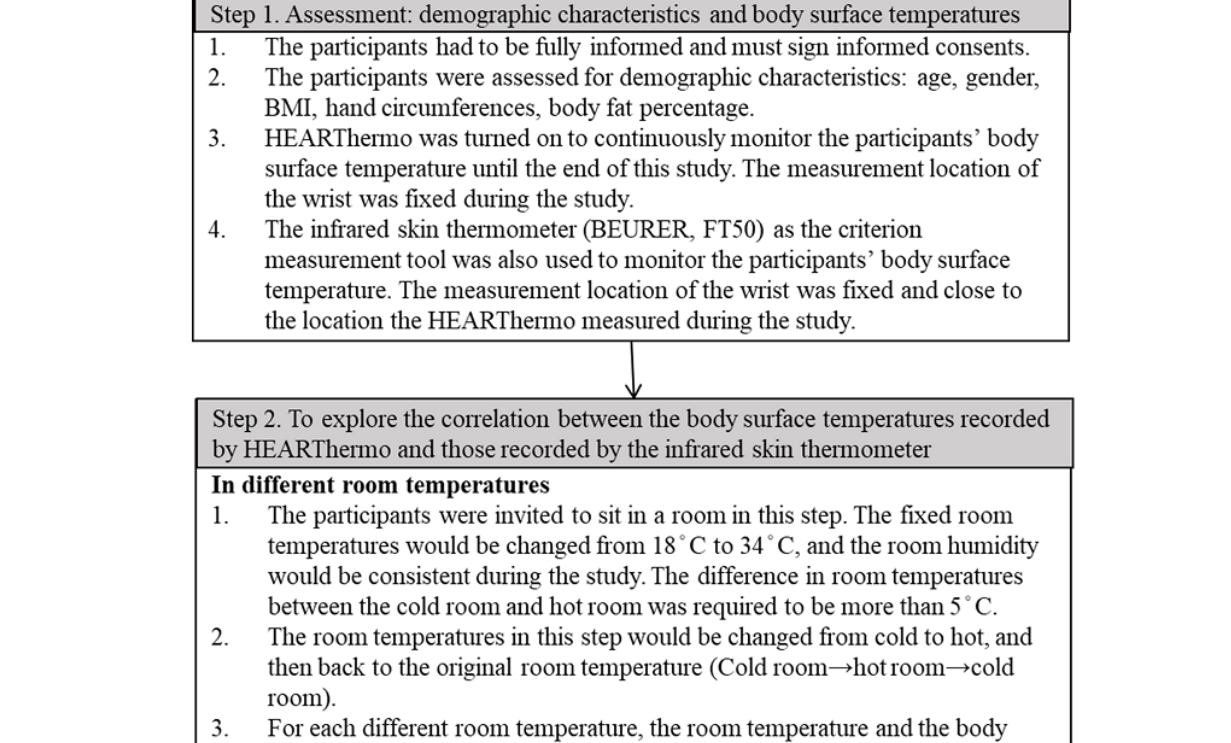
Figure 1. The protocol for validation study